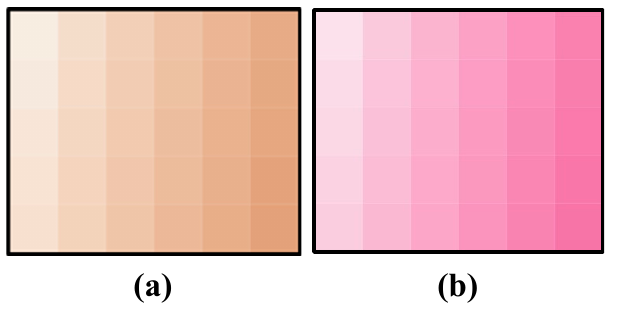
Figure 4. Pigment colors at 30 concentrations: ( a ) melanin component; ( b ) hemoglobin component.